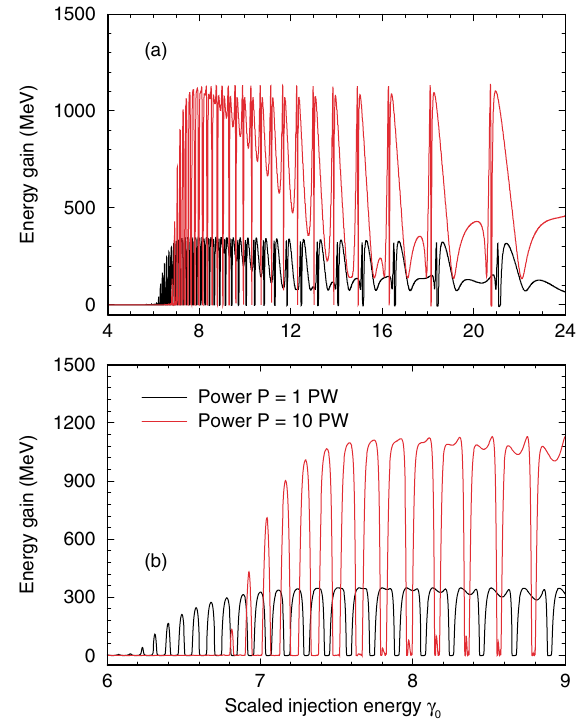
FIG. 10. (Color) Electron energy gain vs the scaled injection energy. In this case the electron is aimed at a point on the beam = 5 to the right of the focus. The laser axis a distance s (cid:3) z r wavelength is (cid:20) (cid:3) 1 (cid:28) m and the intensity parameters are q (cid:17) 26 : 9 (output power 1 PW) and q (cid:17) 85 (power 10 PW). The other (cid:3) 8 (cid:28) m , (cid:6) (cid:3) 6 (cid:1) , z (cid:3) (cid:2) 3 mm , and (cid:3) parameters are w i 0 0 0 0 . Fields to order (cid:1) 5 have been used in the calculation. Note that in (b) we merely zoom in on a small part of (a) and that the legends in (b) apply to (a) as well.